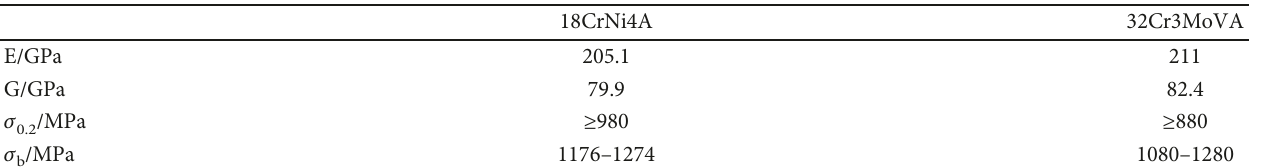
Table 2: Mechanical properties of alloy steels 18CrNi4A and 32Cr3MoVA.